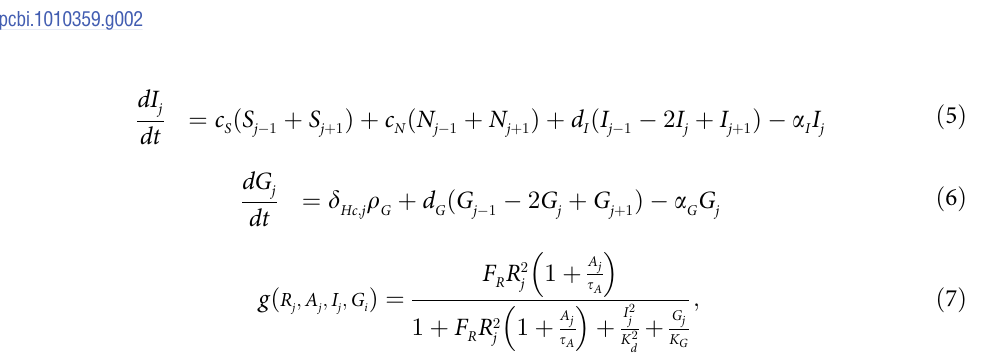
Fig 2. Mechanistic model. The vegetative cells are represented with a soft green background while the heterocyst has a soft yellow background and a thicker cell wall. Genes are represented in rectangles and proteic elements with circles. The dimers are represented with two attached circles and can be inactivated (in green), activated (in brown), and activated and inhibited (in brown with two attached purple inhibitors). Solid lines represent production (with only one simple arrowhead), transformations (with a simple arrowhead in both ends), and interactions (with a double arrowhead). Dashed lines represent inter-cellular traffic and dashed-doted lines represent a transformation when exported to a neighboring